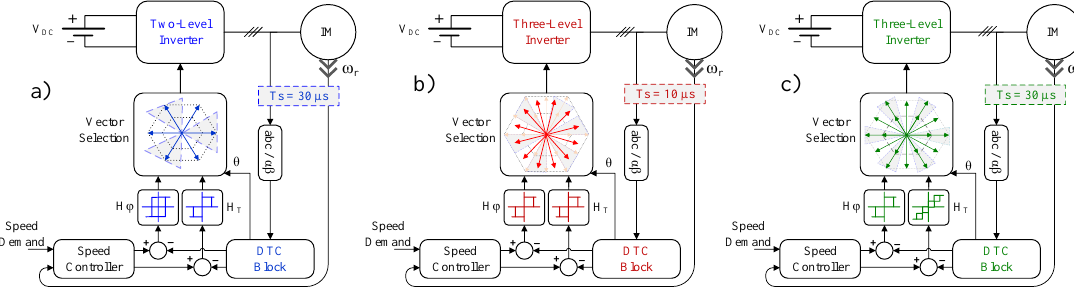
Figure 7. A high-level control scheme of ( a ) conventional, ( b ) vector synthesis and ( c ) proposed DTC drives. HP: